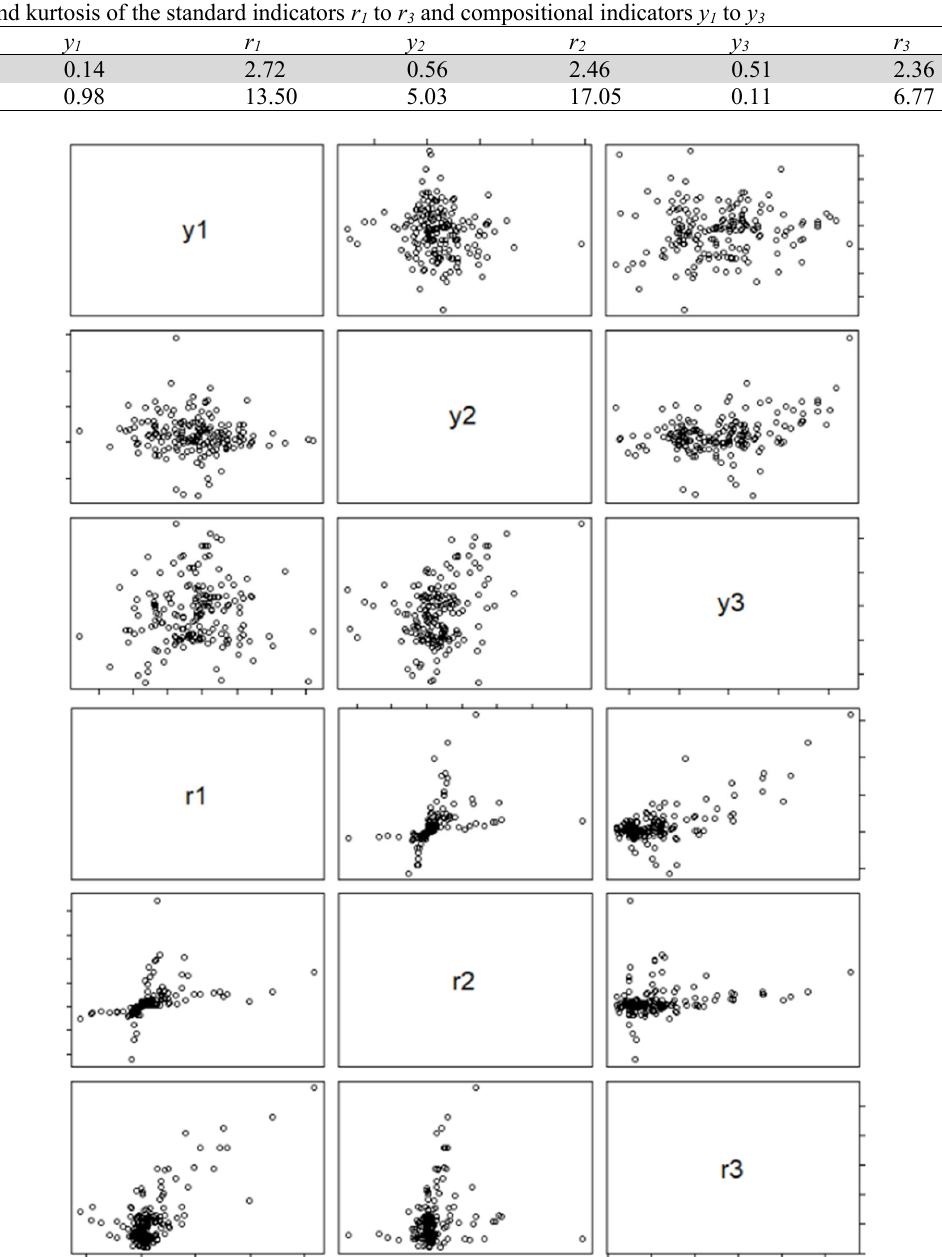
Fig. 2. Scatterplot matrix of the standard indicators r 1 to r 3 and compositional indicators y 1 to y 3